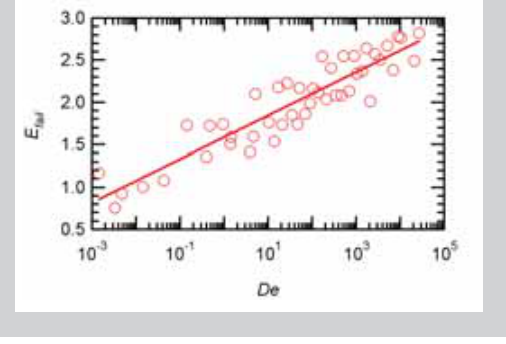
Figure 5: Typical data obtained from FiSER for a strong flour dough. The upper figure shows the measured tensile force and total midplane strain (see Eq. 2); the lower figure shows the computed evolution in the tensile stress. The labeled points indicate: a) large initial aspect ratio, no lubrication regime, b) uni- form uniaxial extension, c) necking, and d) rupture. Figure 6: Non-dimensional plot of final failure strain (E ) ver- fail sus Deborah number (De = te · ) for a range of